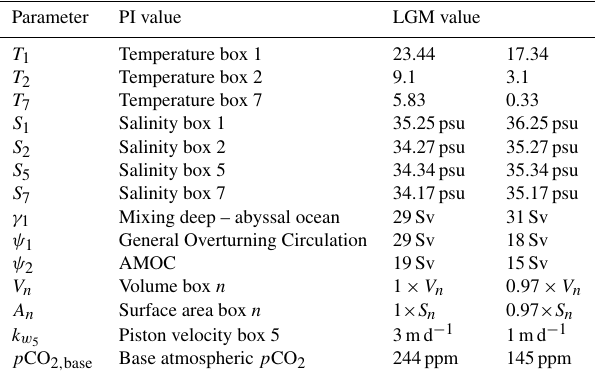
Table 1. The parameter values that are different between the two configurations (PI and LGM). In columns 1 and 2 the parameter symbol and description are given. In column 3 the PI value is given, and in column 4 the LGM value is